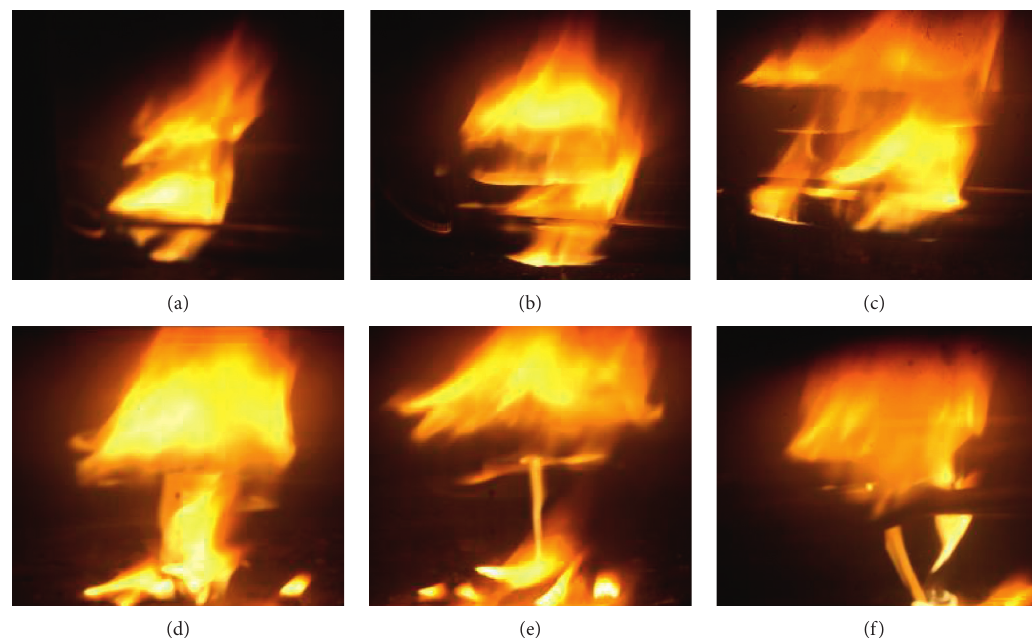
Figure 9: Images of double cable flame spread at a fan frequency of 11Hz. (a) t � 64s, (b) t � 111s, (c) t � 175s, (d) t � 449s, (e) t � 452s, and (f) t �